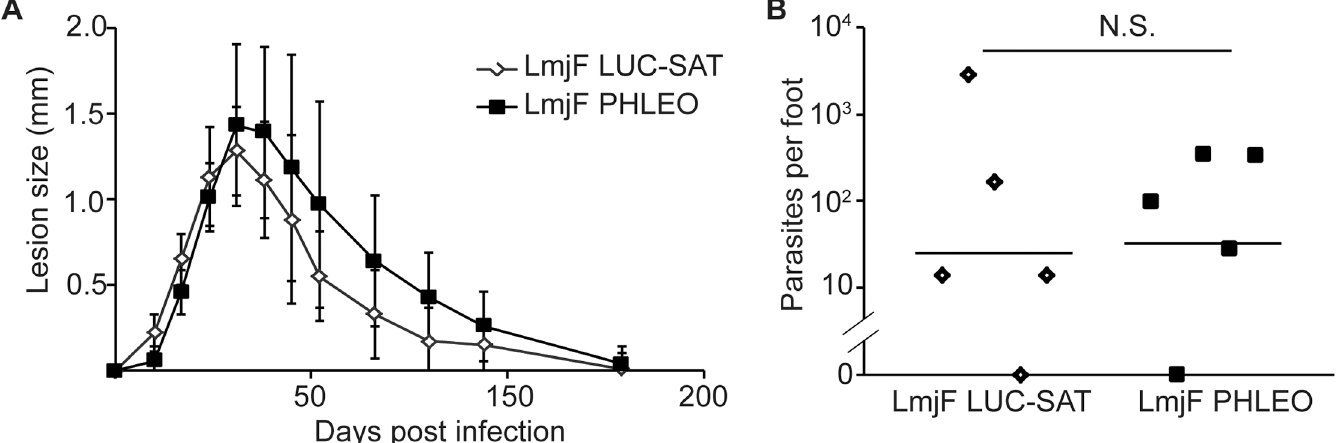
Fig 1. The LmjF-LUC-SAT and LmjF-PHLEO strains show comparable virulence in infections of resistant mice. C57BL/6 mice (5 per group) were infected with 10 5 metacyclic stage LmjF-LUC-SAT or LmjF-PHLEO L . major . (A) Measurements of lesion pathology (increase in footpad thickness). Error bars show the standard deviation. (B) Persistent parasites numbers were determined by limiting dilution assay from footpad tissue 130 days post infection. Horizontal bars show the geometric mean. † , P > 0.05.